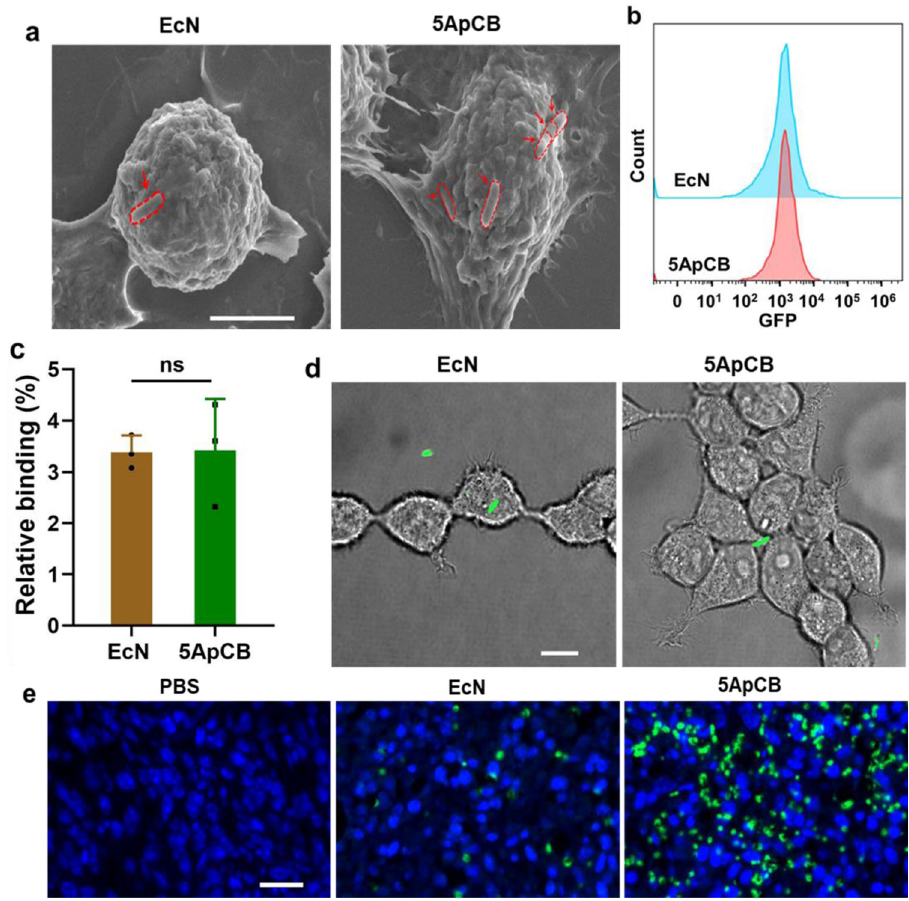
Fig. 3 Speci fi c binding of ApCB with cancer cells. a Representative SEM images of 4T1 cells after incubation with EcN and 5ApCB at 37 °C for 2 h, respectively. Bacteria were circled by a red dotted line. Images are representative of three independent biological samples. Scale bar: 5 µ m. b Flow cytometric analysis of 293T cells after co-incubation with EcN GFP and 5ApCB GFP at 37 °C for 2 h, respectively. c Percentages of 293T cells binding with EcN GFP and 5ApCB GFP after co-incubation at 37 °C for 2 h, respectively. Error bars represent the standard deviation ( n = 3 independent experiments). Data are presented as mean values ± SD. Signi fi cance was assessed using Student ’ s t test (two-tailed). ns: no signi fi cance. d Typical LSCM images of 293T cells after incubation with EcN GFP and 5ApCB GFP at 37 °C for 2 h, respectively. Cells were rinsed with PBS before observation. Green channel means EcN producing GFP. Images are representative of four independent biological samples. Scale bar: 10 µ m. e Confocal images of tumor tissues sectioned at 12 h after intravenous injection of 1 × 10 7 CFU bacteria. Green and blue indicate EcN stained with FITC-labeled anti- Escherichia coli and nuclei stained with